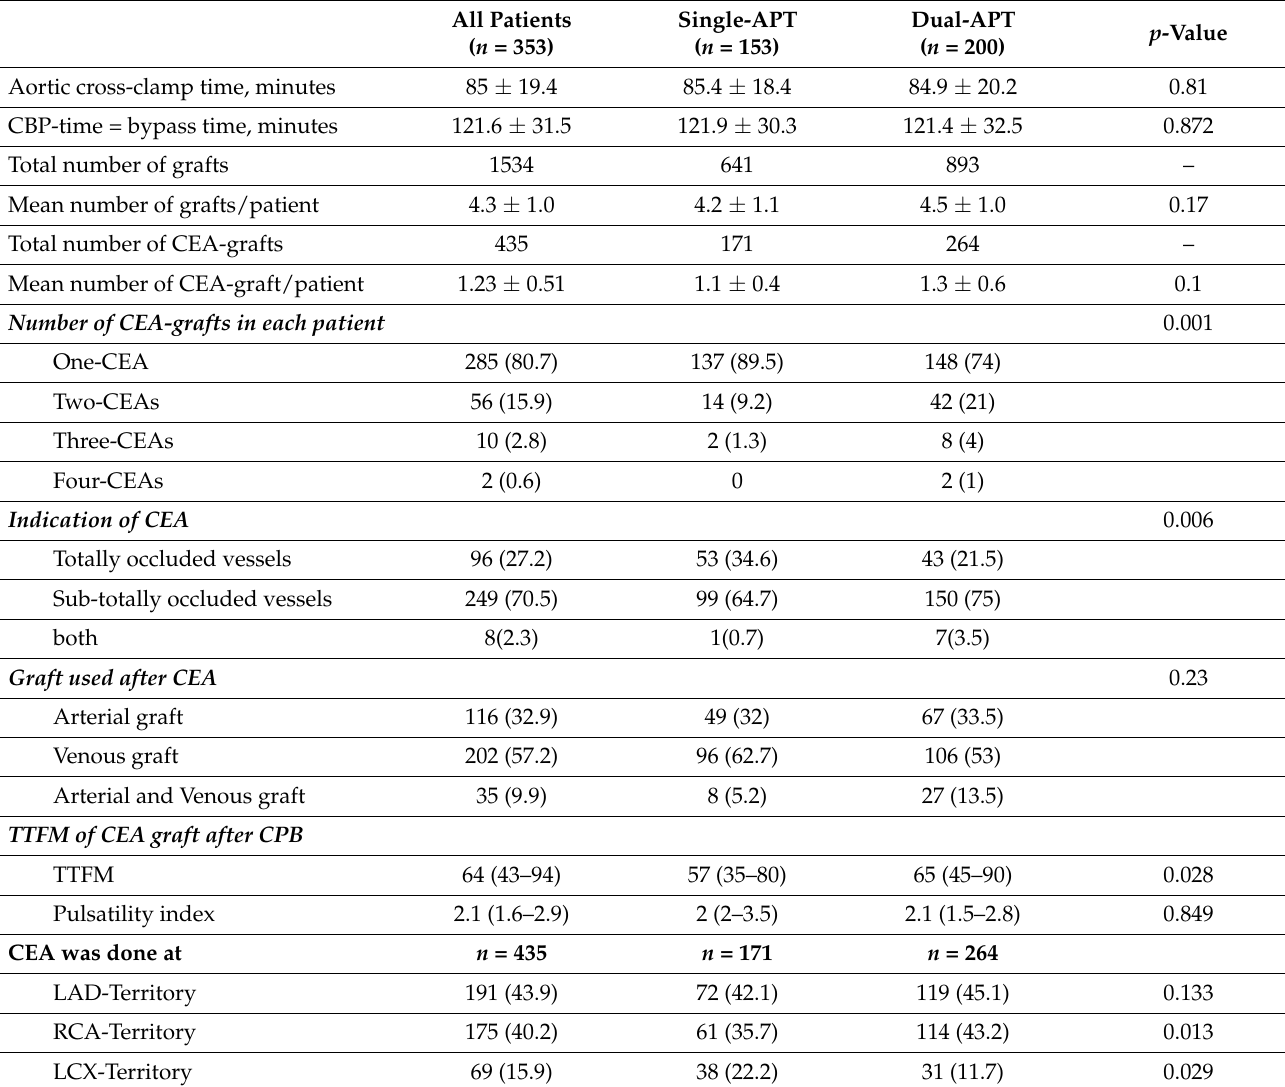
Table 2. Intraoperative Outcomes.